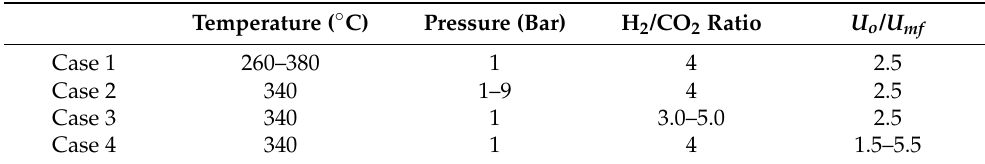
Table 2. Experimental conditions for CO 2